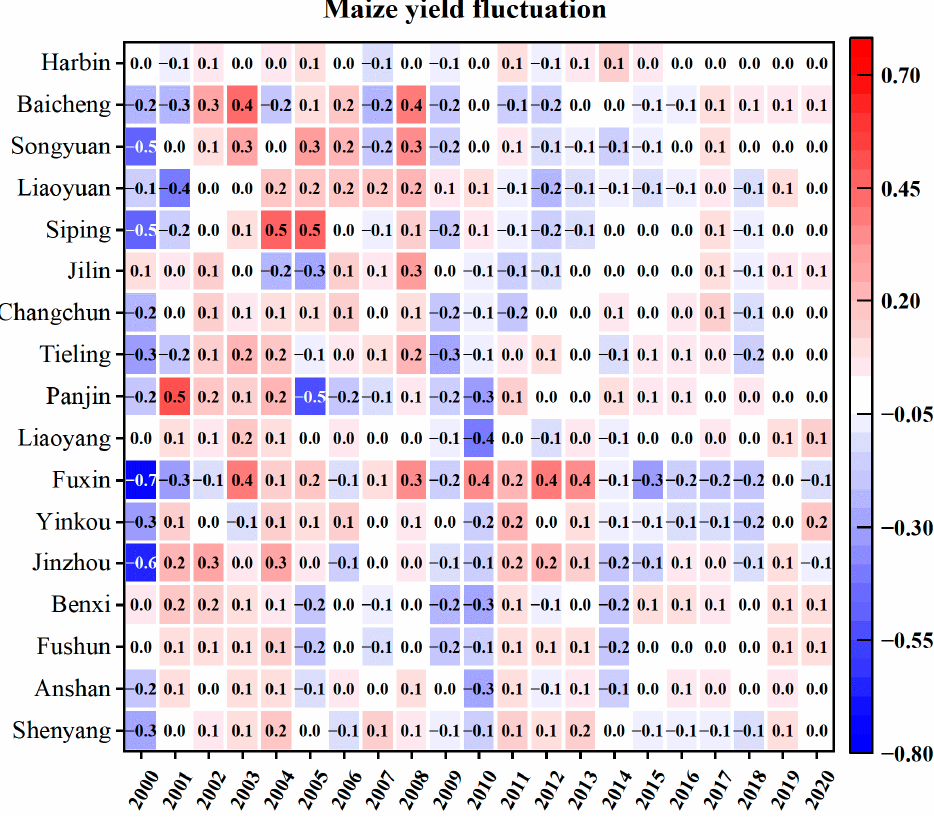
Figure 14. Heat map of yield fluctuations .